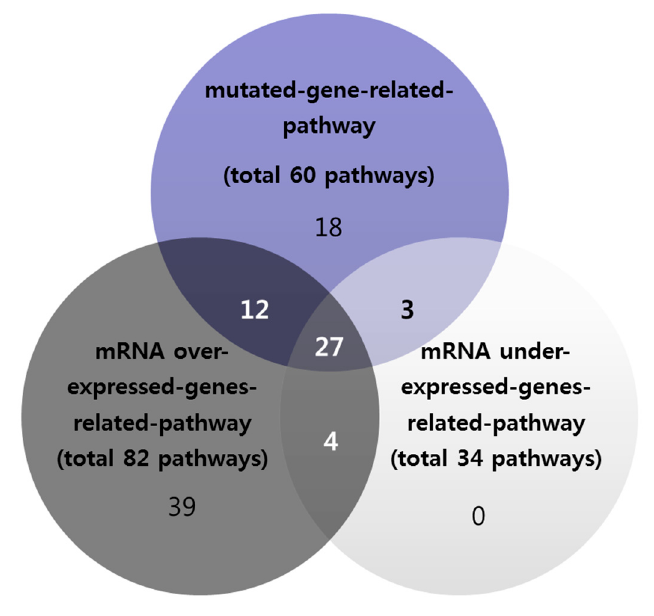
Figure 2. Comparison of mutation-based pathways, over-expressed genes-based pathways, and under-expressed genes-based pathways.